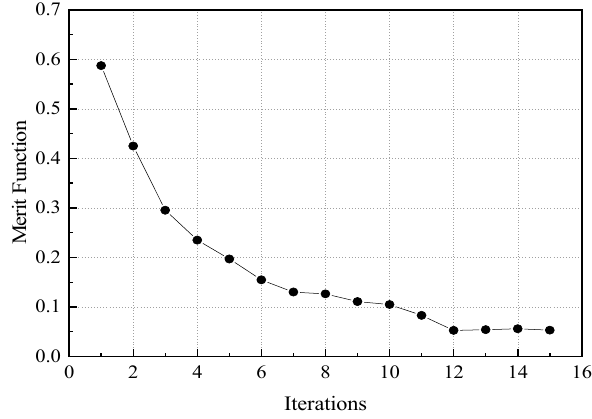
Figure 9. The value of the merit function with iterations.